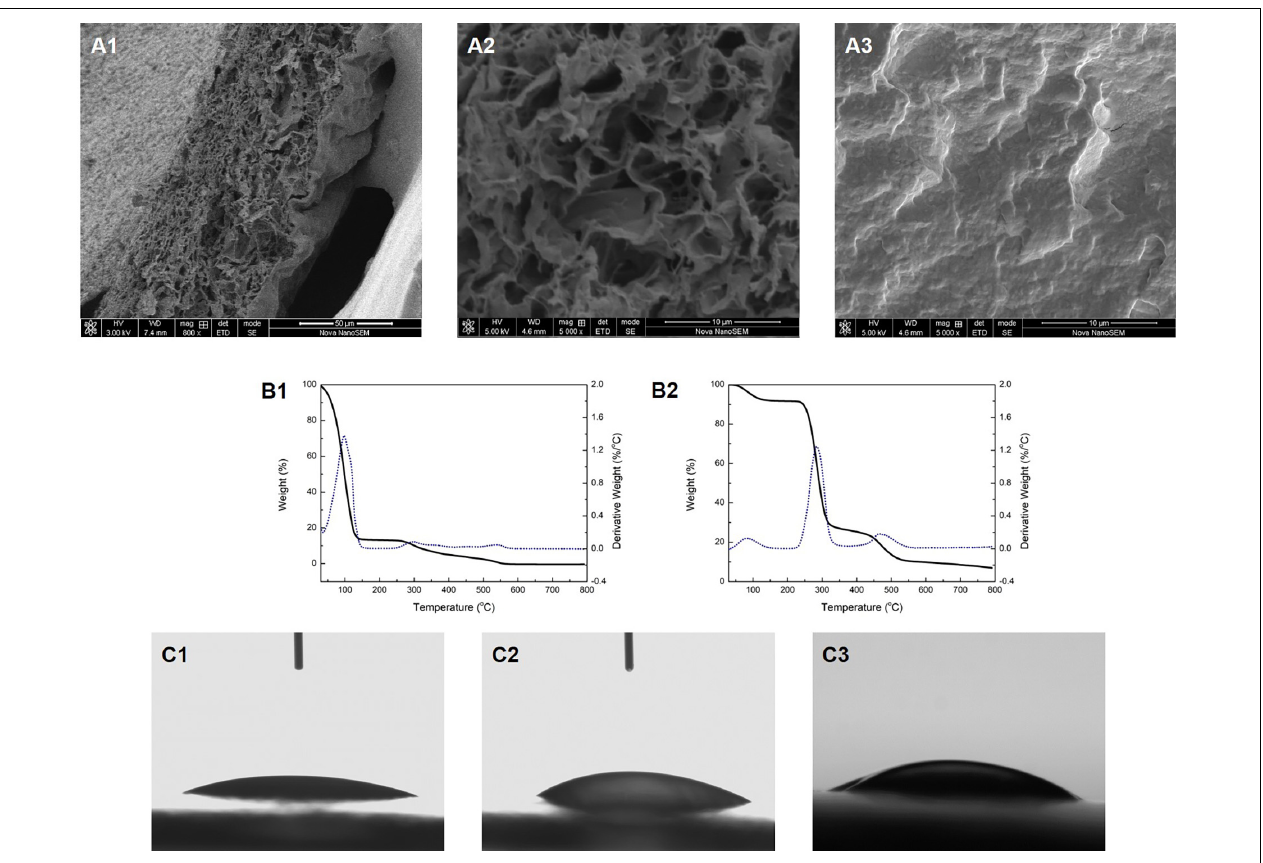
FIGURE 1 | The cross-section morphology of the Col/PVA dual-layer membrane showing (A1) both layers, (A2) collagen layer, (A3) PVA layer. TG analysis of (B1) Col/PVA dual-layer membrane, (B2) pure PVA membrane. WCA of (C1) collagen side, (C2) PVA side of the Col/PVA dual-layer membrane, (C3) pure PVA